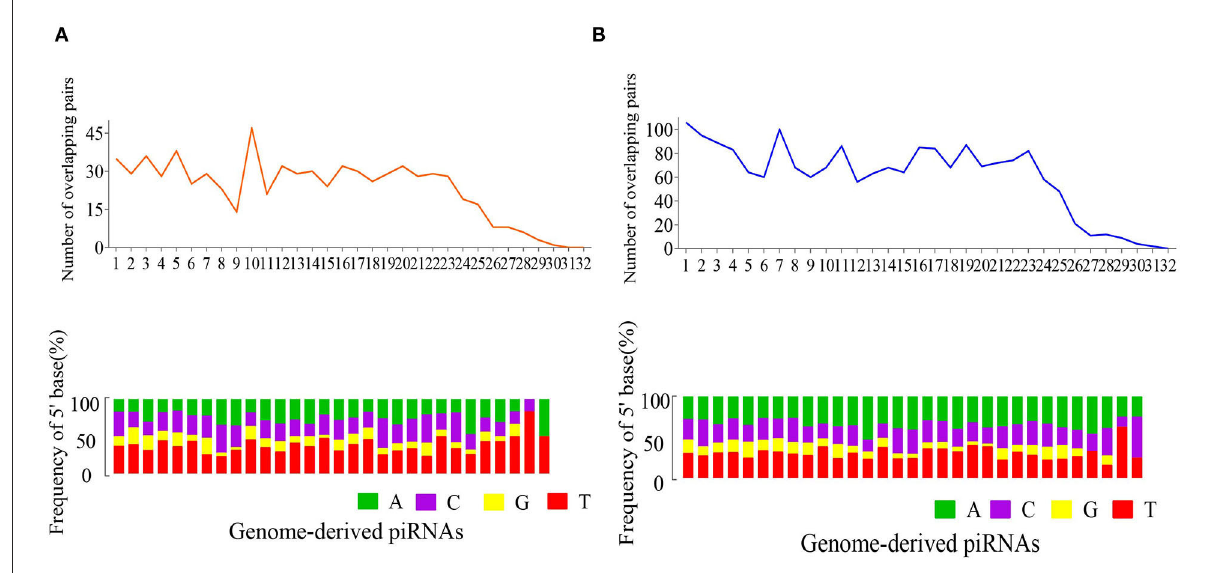
FIGURE4 Overlapping pairs and the 5 ′ base frequencies of genome-derived piRNAs in FP (A) and LP (B) .